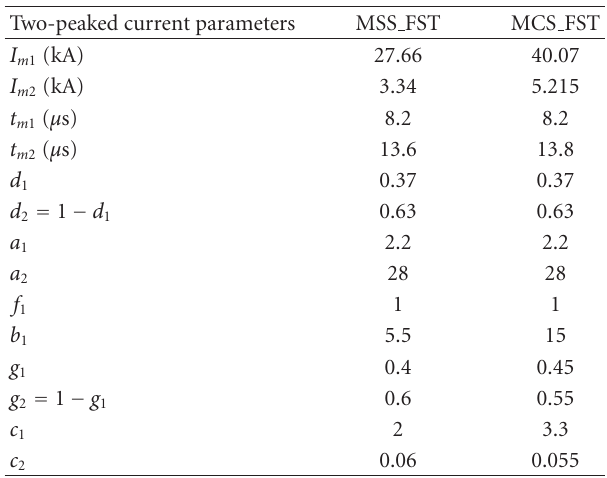
Figure 1: Two-peaked channel-base current function (full line) approximating the measurements results from [3] with the ade- quate function from [13] (dashed line). Table 1: Two-peaked current function parameters to approximate channel-base currents MSS FST [3] and MCS FST